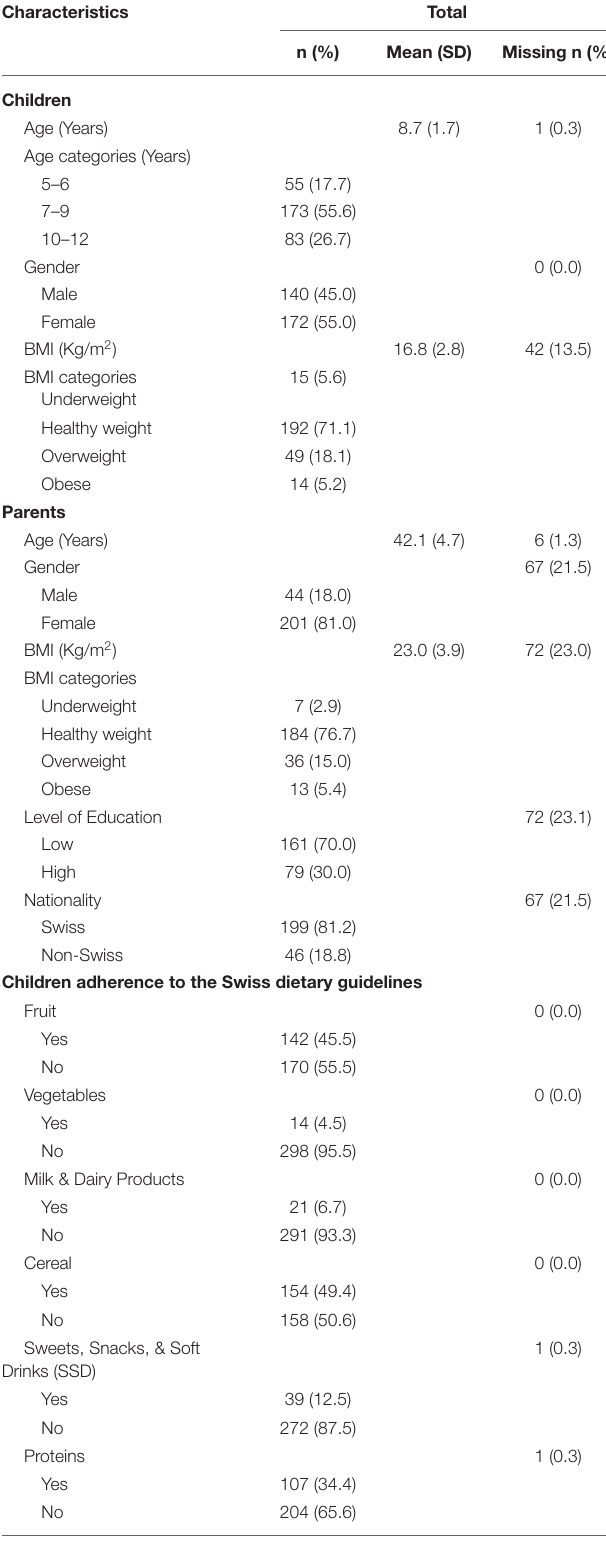
TABLE 1 | Descriptive characteristics of the analysis sample at baseline ( n = 312), Switzerland 2012.